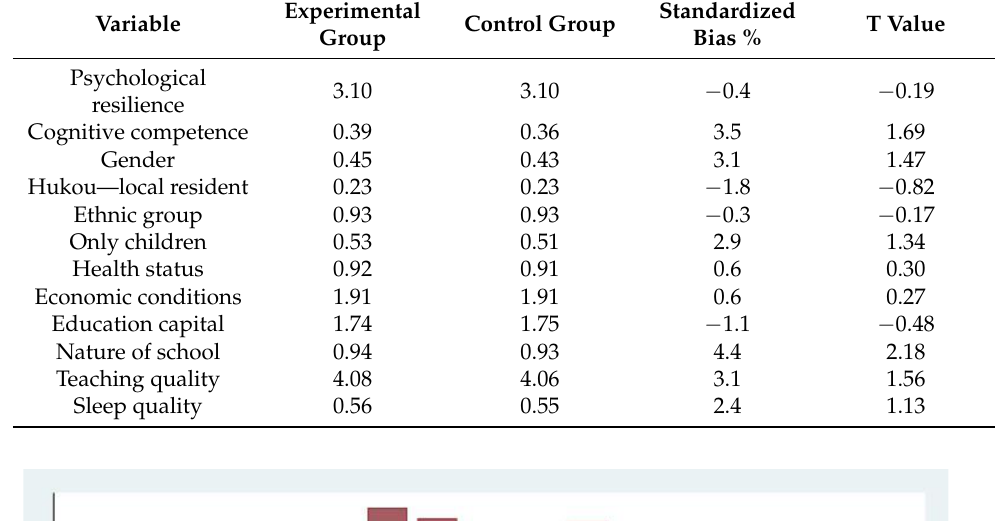
Table 5. Sample balancing test (on and off support).